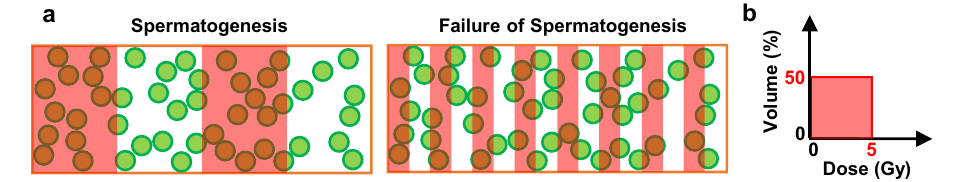
Figure 6. Failure of conventional radiological does-volume concept in the ex vivo spermatogenesis. ( a ) Two different 50% micro-slit irradiation patterns of the ex vivo testes tissues. They had the same irradiated area of 50% and the same total irradiation dose, of 2.5 Gy at the whole tissue level. Green circles and red squares are germ cells and irradiated areas, respectively. ( b ) Dose-volume histograms of the two 50% micro-slit